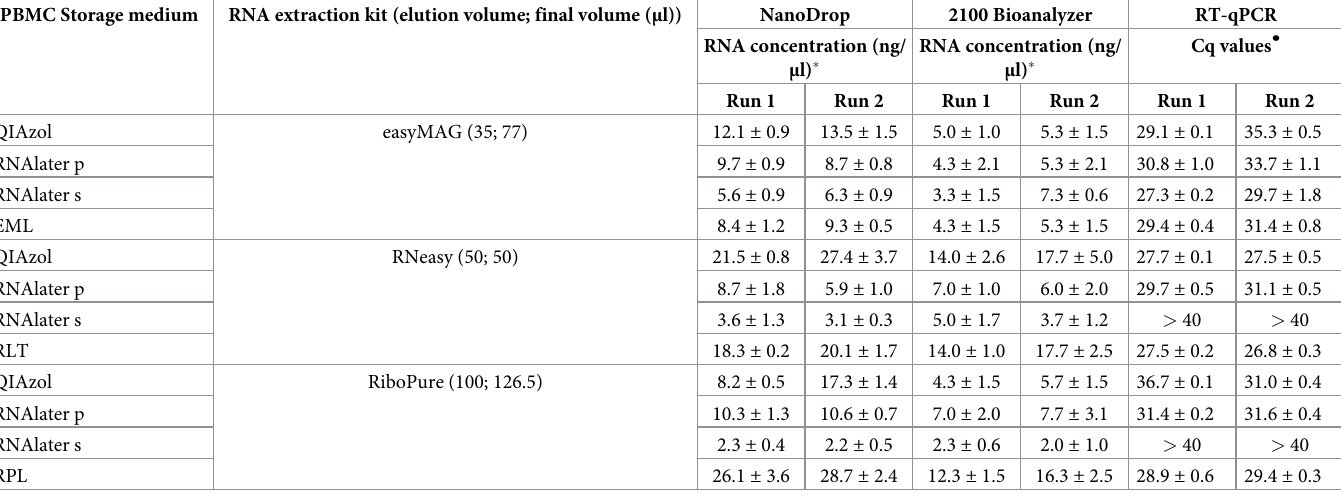
Table 3. RNA quantification according to NanoDrop spectrophotometer, 2100 Bioanalyzer and RT-qPCR for the ACTB gene, for two runs of three different RNA extraction kits after storage of PBMCs in three different storage media. PBMC Storage medium RNA extraction kit (elution volume; final volume ( μ